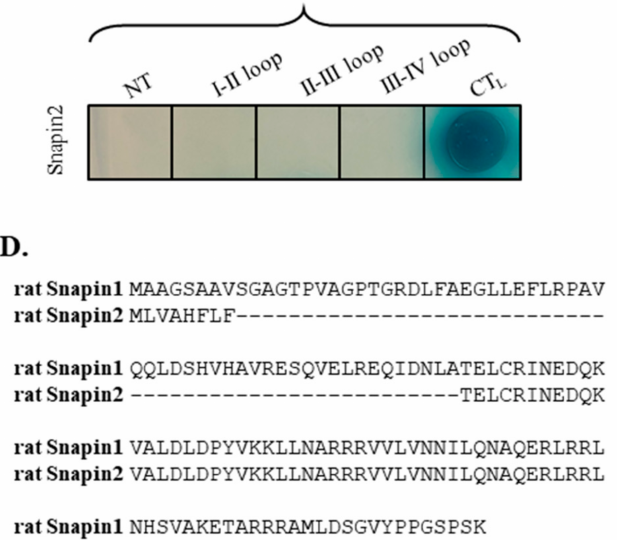
Figure 1. Isolation of rat Snapin2 as an interaction partner with the CT L of rat Ca v 1.3 by yeast- two-hybrid (Y2H) screenings. ( A ) Schematic diagram of rat Ca v 1.3 L α 1 subunit. The amino acid numbers for the intracellular structures of rat Ca v 1.3 L α 1 subunit, including NT (amino terminus), I–II, II–III, III–IV, and CT L are designated in parentheses. ( B ) Y2H data representing an interaction between the CT L and rat Snapin2. A positive clone containing rat Snapin2 construct was isolated from Y2H screenings for which the CT L and a rat brain library were used as bait and prey, respectively. Co-transformation of the CT L and rat Snapin2 produced a blue colony in a high-stringent condition ( − Ade, − His, − Leu, and − Trp) with X-gal. ( C ) Y2H results illustrating that rat Snapin2 interacted with only the CT L but not with the other intracellular structures. ( D ) Amino acid sequence alignment between rat Snapin1 and